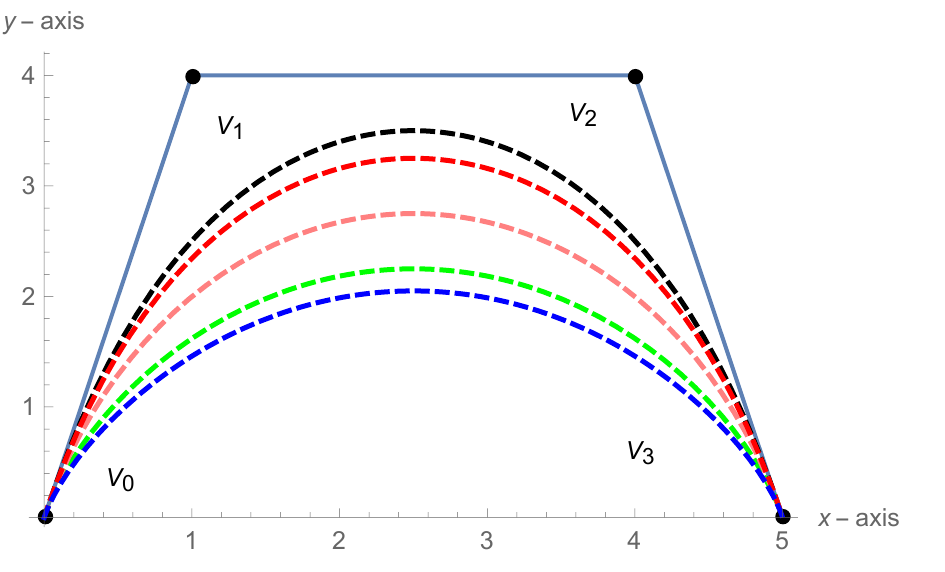
Figure 3. Cubic Bézier curve for different values of shape parameters.